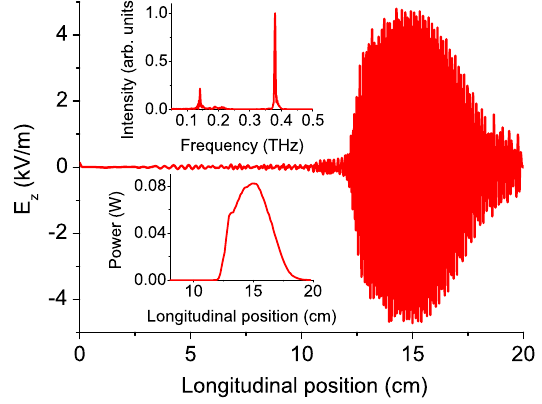
6. The same as that of Fig. 5, when the coherence factor is resonant at TM 02 mode ( Δ τ ¼ 1 · 2 ¼ 5 . 2 ps) and the 0 . 3842 THz beam energy is 150 keV.